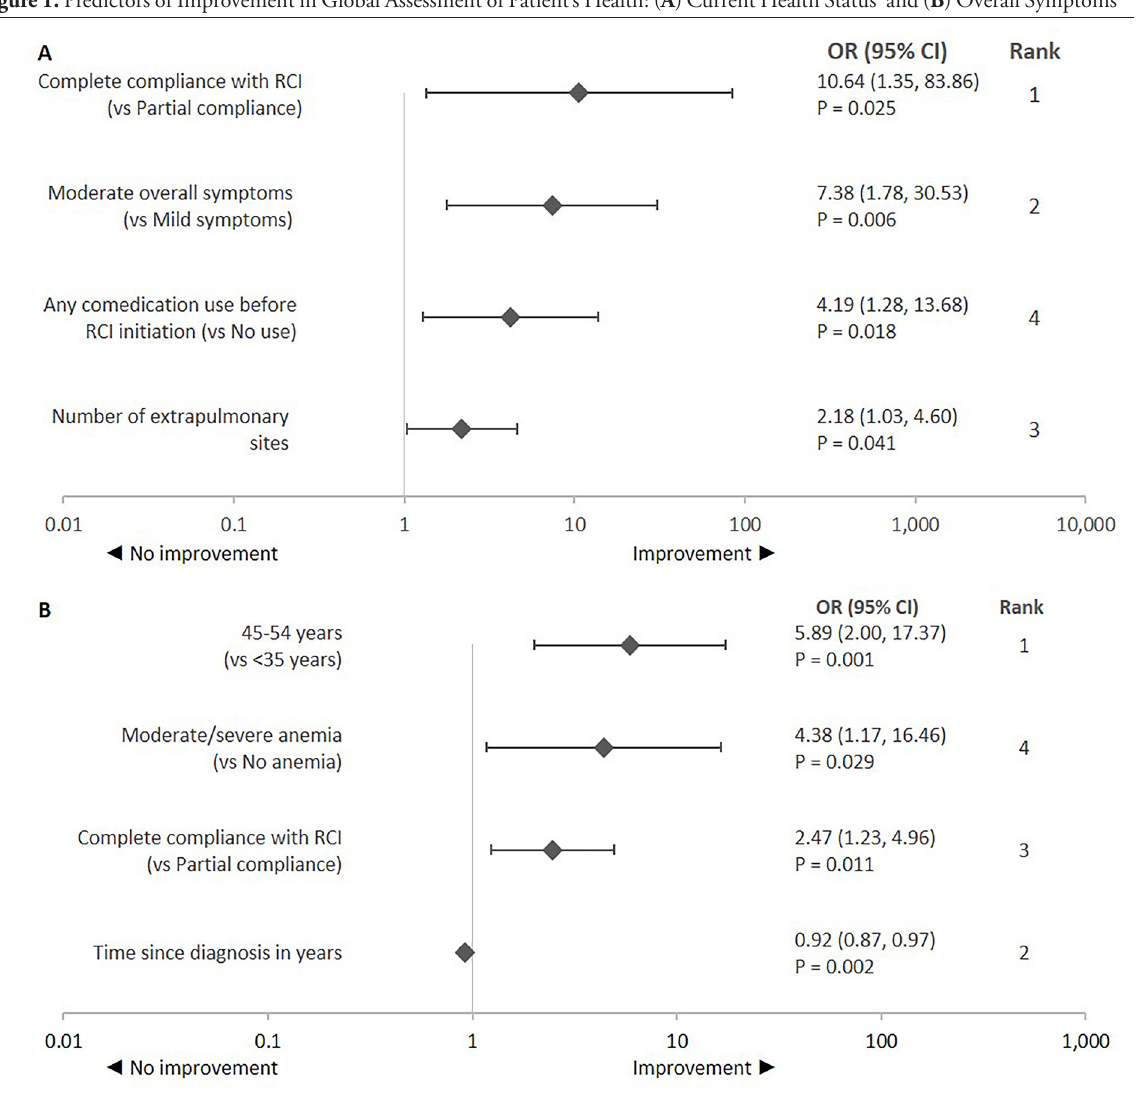
Figure 1. Predictors of Improvement in Global Assessment of Patient’s Health: ( A ) Current Health Status a and ( B ) Overall Symptoms